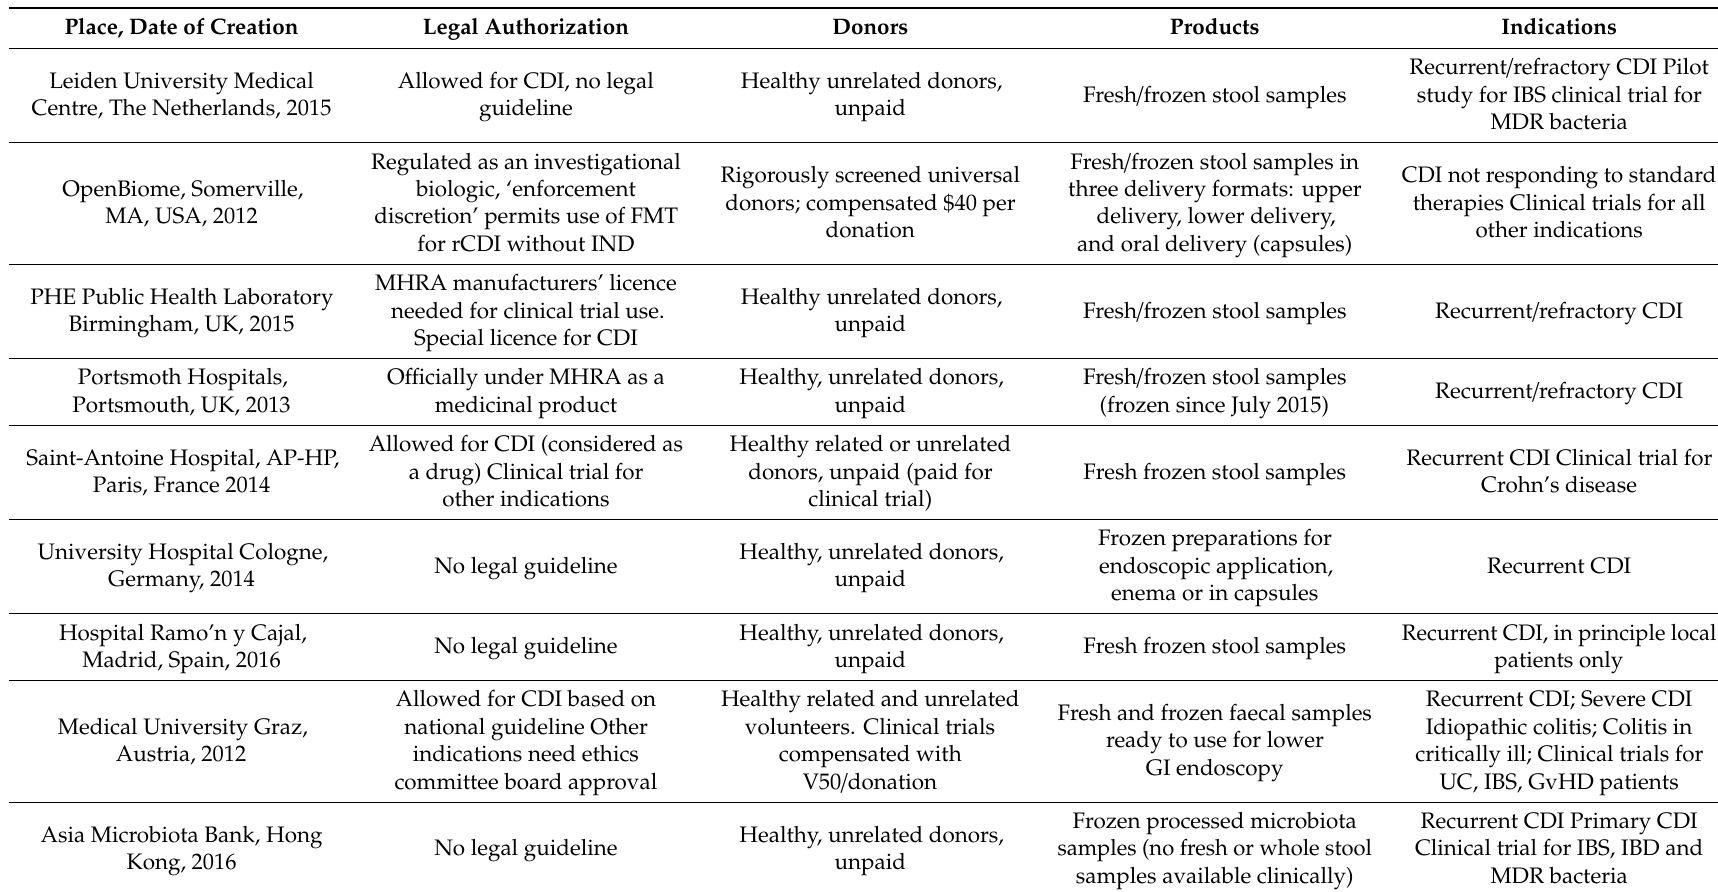
Table 4. List of existing worldwide stool